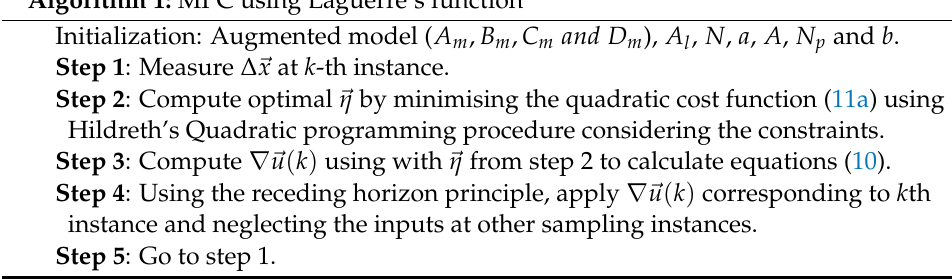
Algorithm 1: MPC using Laguerre’s